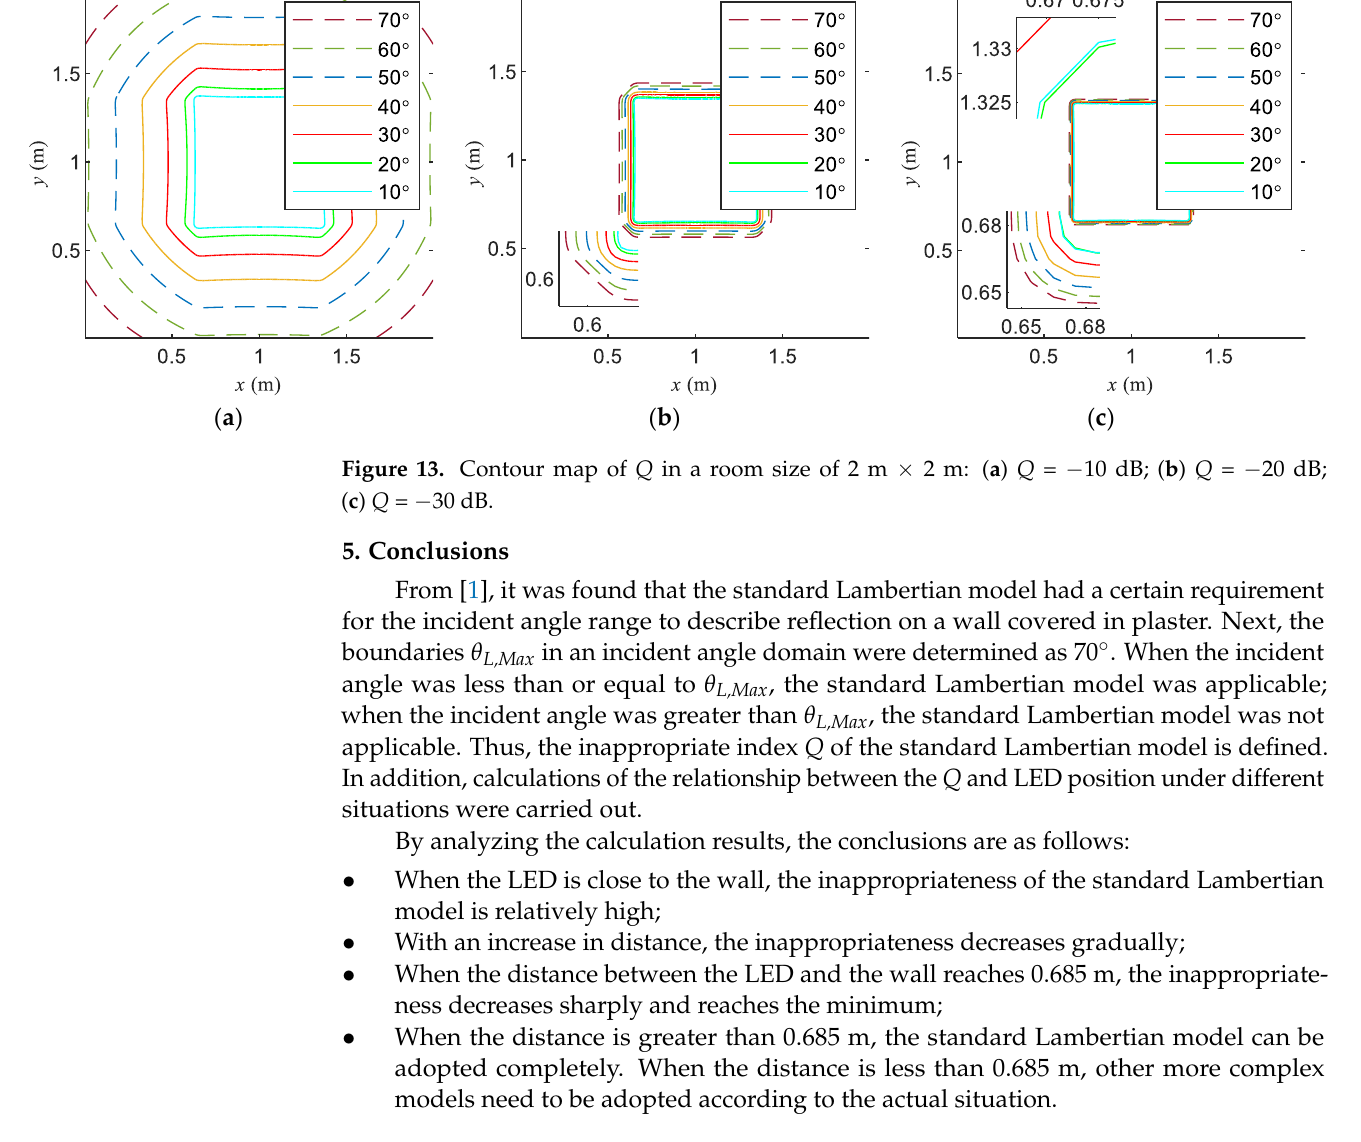
( f ) ( g ) Figure 12. Calculation results of the relationship between the Q and LED position at a room size of 2 m × 2 m: ( a ) θ 1/2 = 10°; ( b ) θ 1/2 = 20°; ( c ) θ 1/2 = 30°; ( d ) θ 1/2 = 40°; ( e ) θ 1/2 = 50°; ( f ) θ 1/2 = 60°; ( g ) θ 1/2 = 70°. According to the calculation results in Figure 12, the distance between the edge of the region with a minus infinity Q and the wall boundary was 0.685 m, but when the room